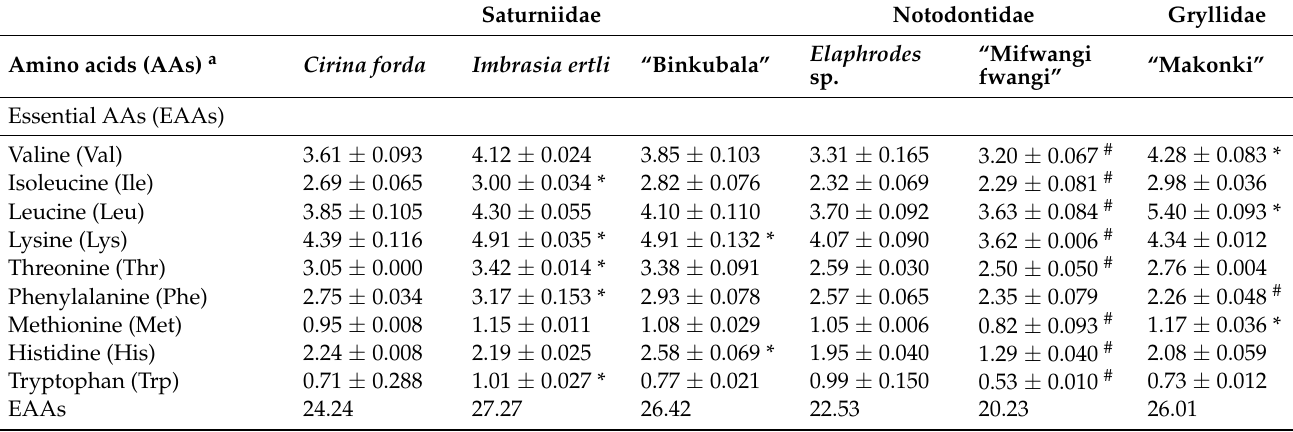
Table 3. AA composition (g/100 g DM) of the main commercial edible insect